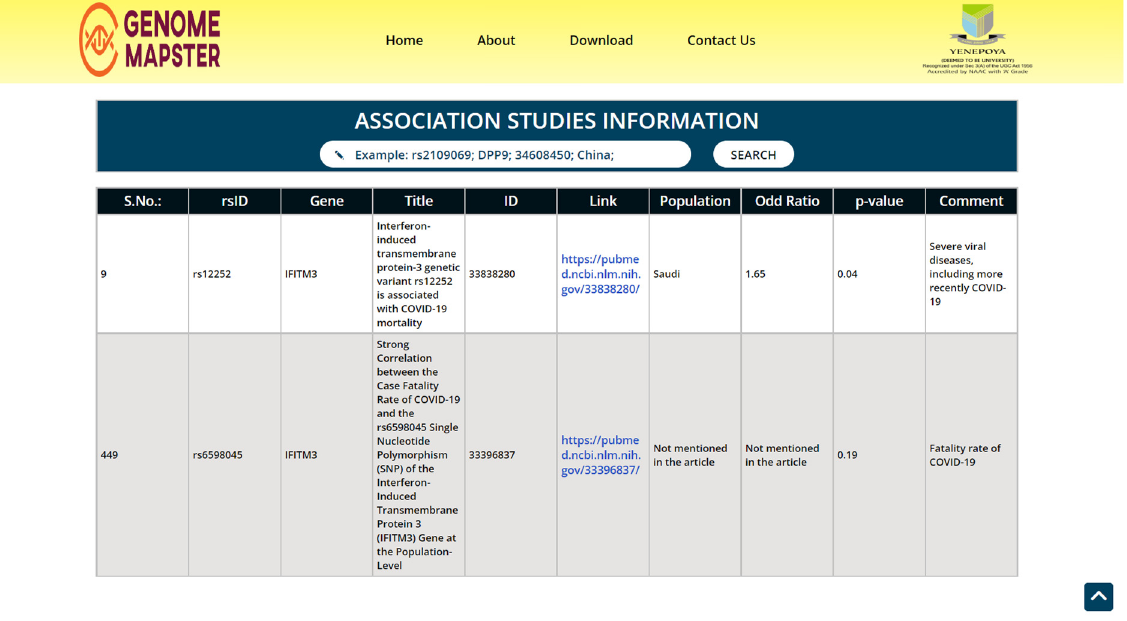
Figure 3. The snapshot of the results page, which fetches all the information in a table format based on the gene name, e.g. “ IFITM3 (Interferon-induced transmembrane protein 3) ,” as a search word. on the gene name, e.g., “ IFITM3 (Interferon-induced transmembrane protein 3) ,” as a search